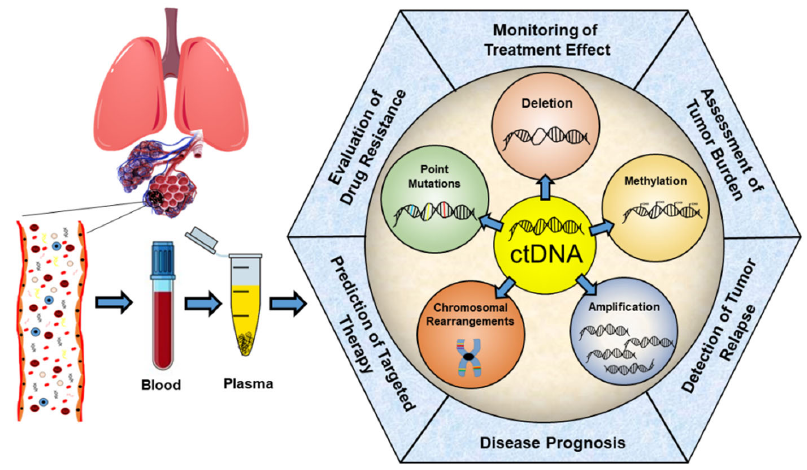
Figure 1. Current research areas of ctDNA application in non ‐ small ‐ cell lung cancer management.